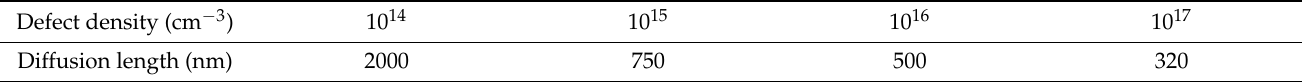
Table 3. Variation of carrier diffusion length for the corresponding absorber defect